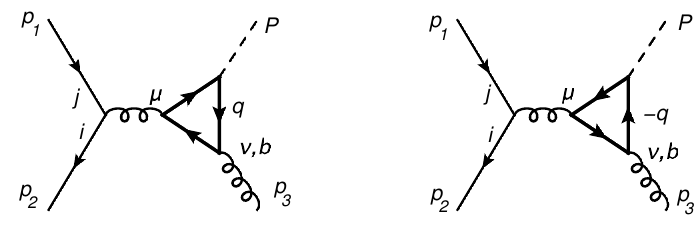
Figure 1 . Feynman diagrams for q (cid:22) q ! H + g at